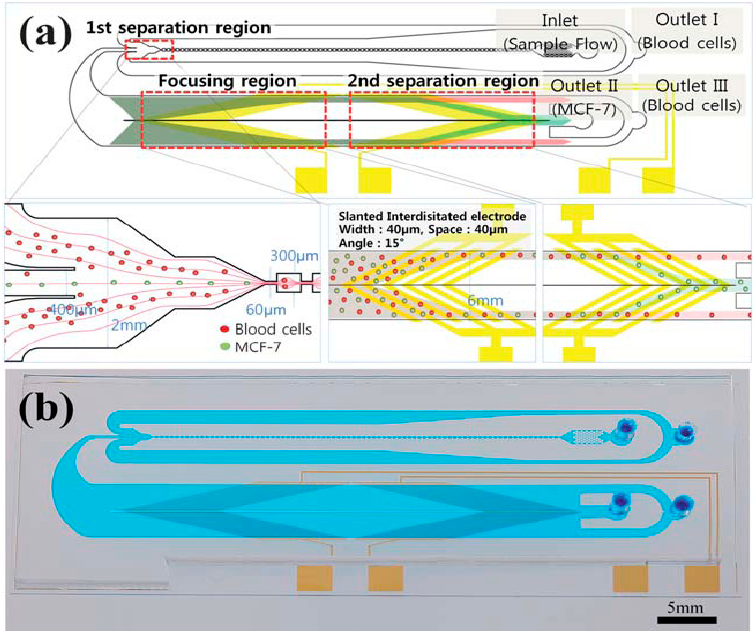
Figure 12. ( a ) Schematic diagram of the microdevice for cell separation using multi-orifice flow fractionation (MOFF) and DEP. In the first separation region, the relatively larger cancer cells and a few blood cells passed through the center channel and entered the DEP channel, after which most blood cells exited through outlet I. In the focusing region, all cells experienced a positive DEP force